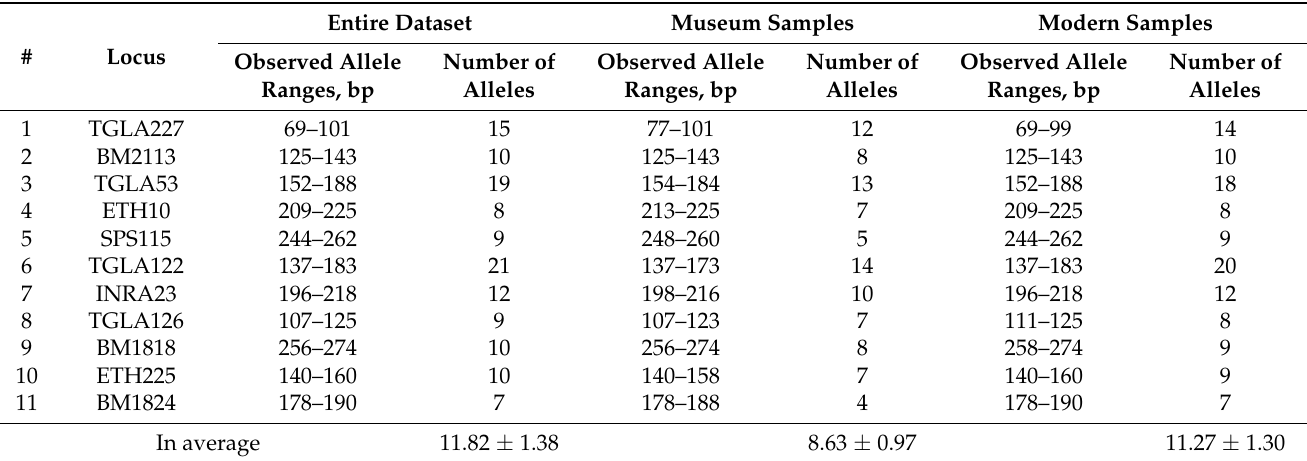
Table 1. Number of identified alleles among microsatellite loci in studied cattle populations